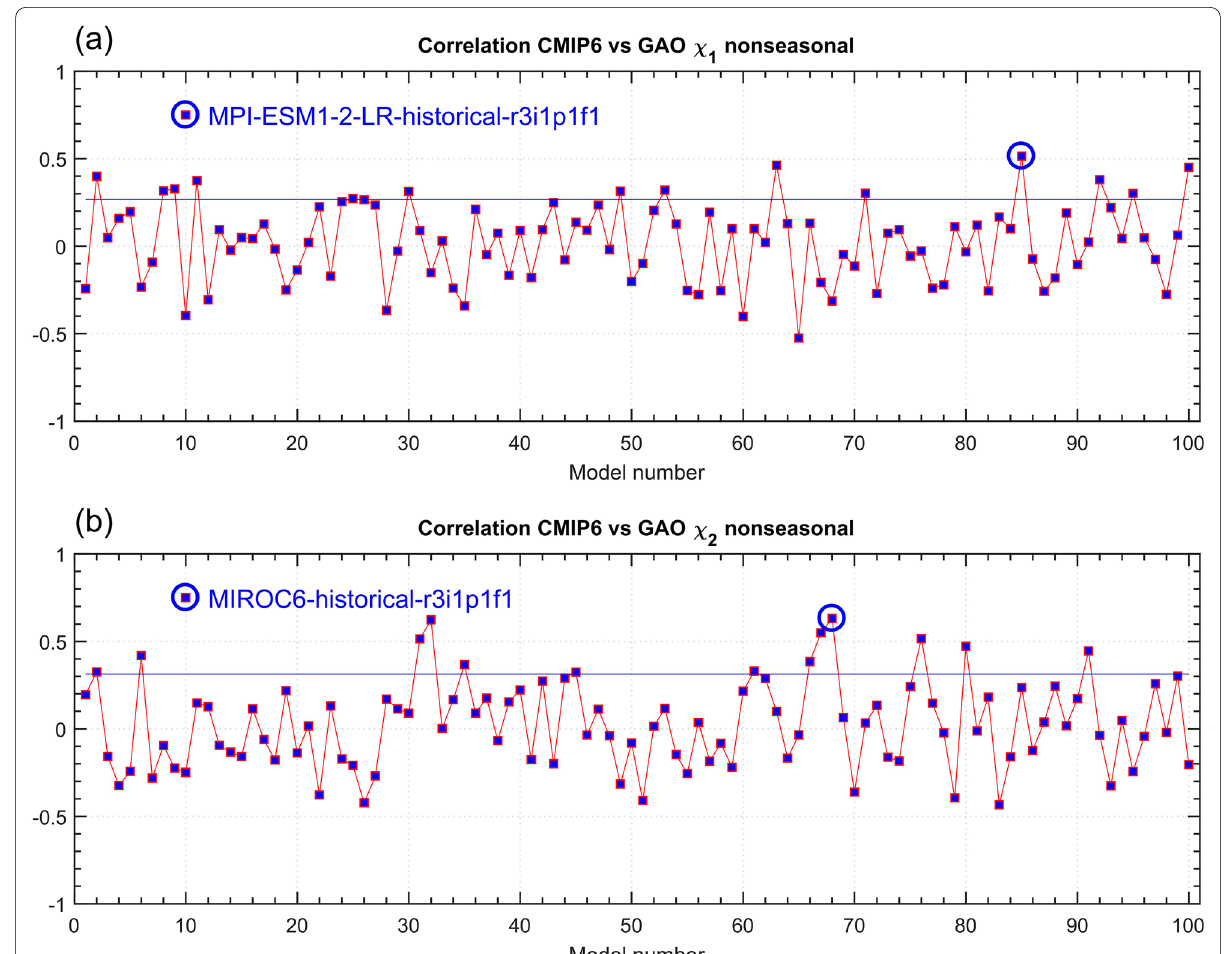
Fig. 11 Correlation coefficients between GAO and HAM from CMIP6 for a χ 1 non-seasonal component and b χ 2 non-seasonal component. Blue lines represent the first quantile. The model with the highest correlation coefficients is indicated by a circle and label